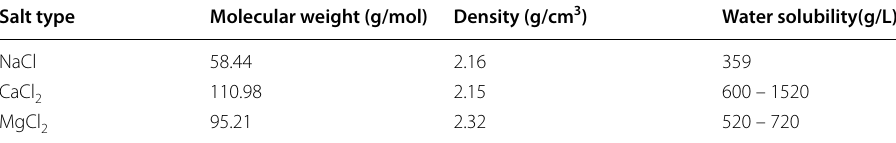
Table 1 Properties of brine